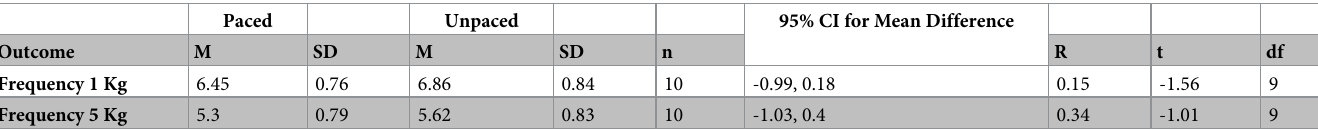
decreased by 19.11% from the load weight of 1 to 5 kg, which is in agreement with the findings